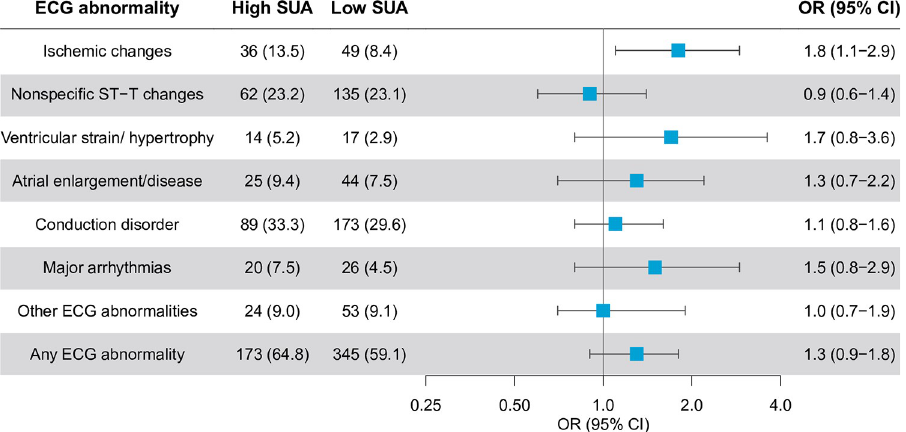
PLOS ONE | https://doi.org/10.1371/journal.pone.0283839 March 30,